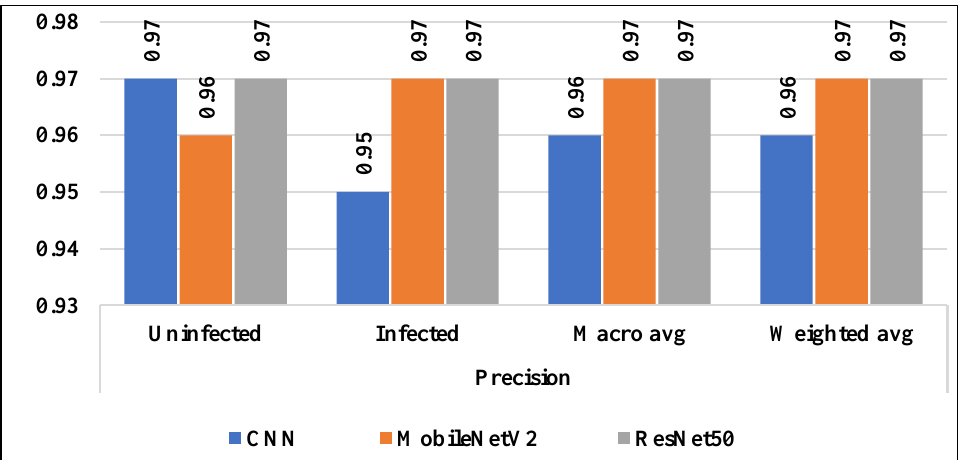
Figure 16. Precision of all considered models.